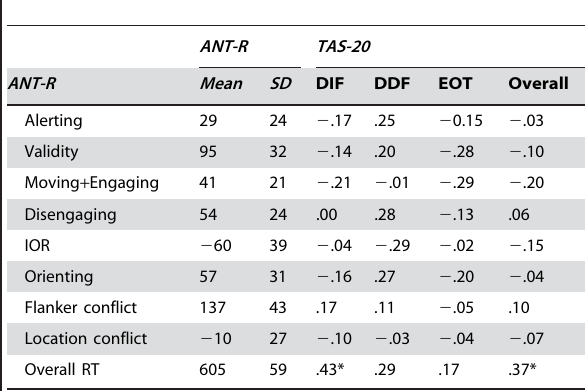
Table 2. Means and SDs of ANT-R, and their correlations with